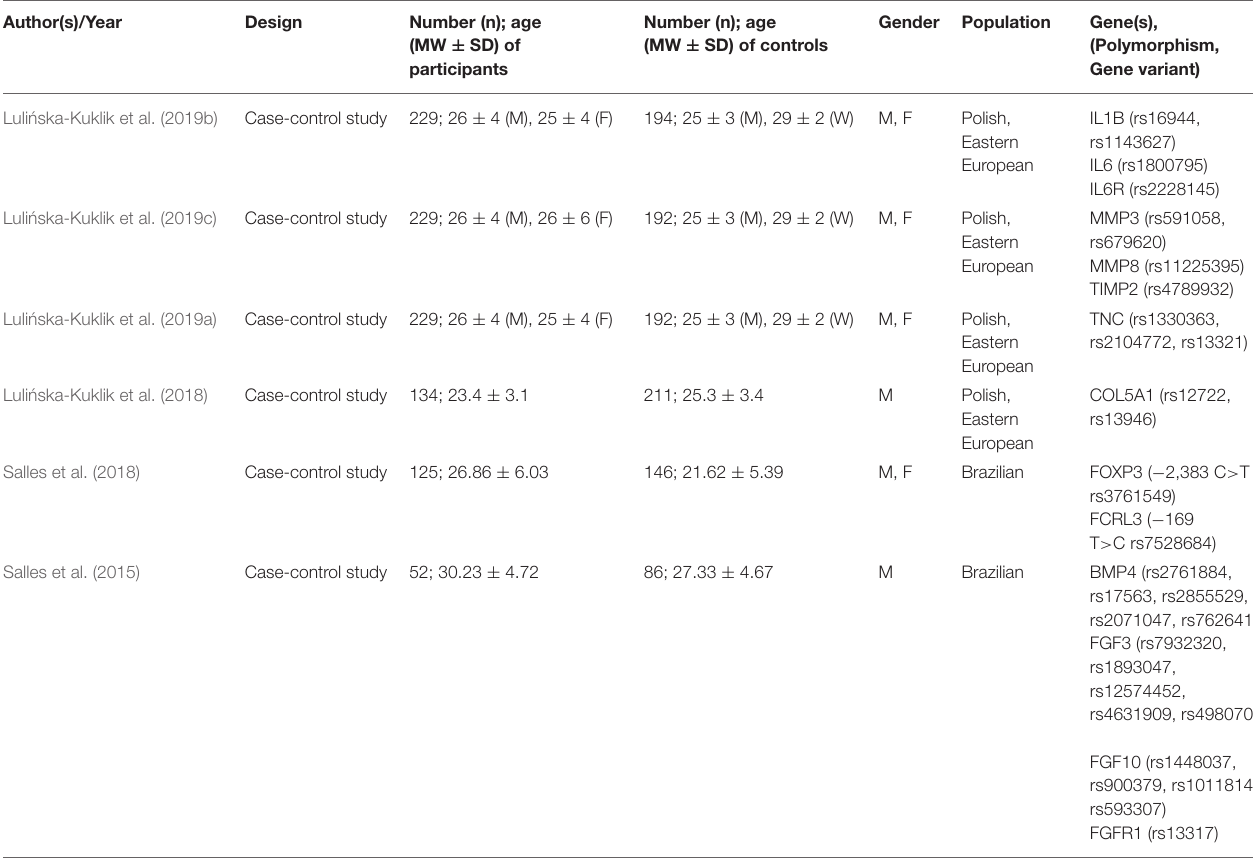
TABLE 4 | Presentation of characteristics of included injury susceptibility